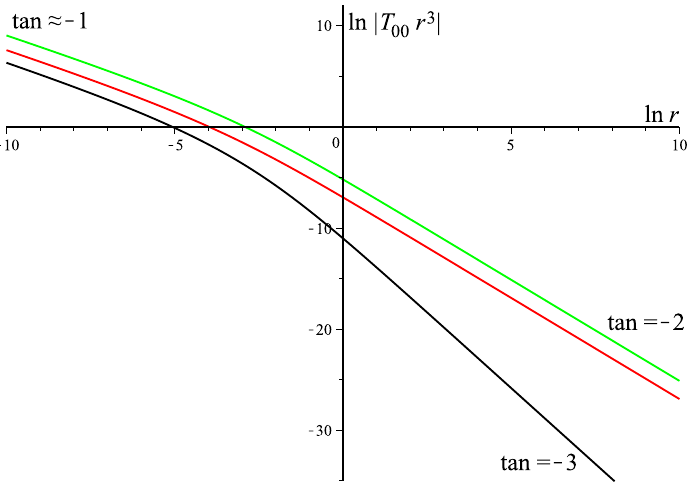
Figure 7. Plots of the vacuum energy density (times overall factor r 3 ) in doubly logarithmic mode ( α = 1): for the total EMT (cid:104) T 00 (cid:105) ren ( ξ = 0, red), for conformal tensor ˜ T 00 (black), and for ”anti- conformal” tensor − ¯ T 00 ( ξ ) ( ξ = 0,